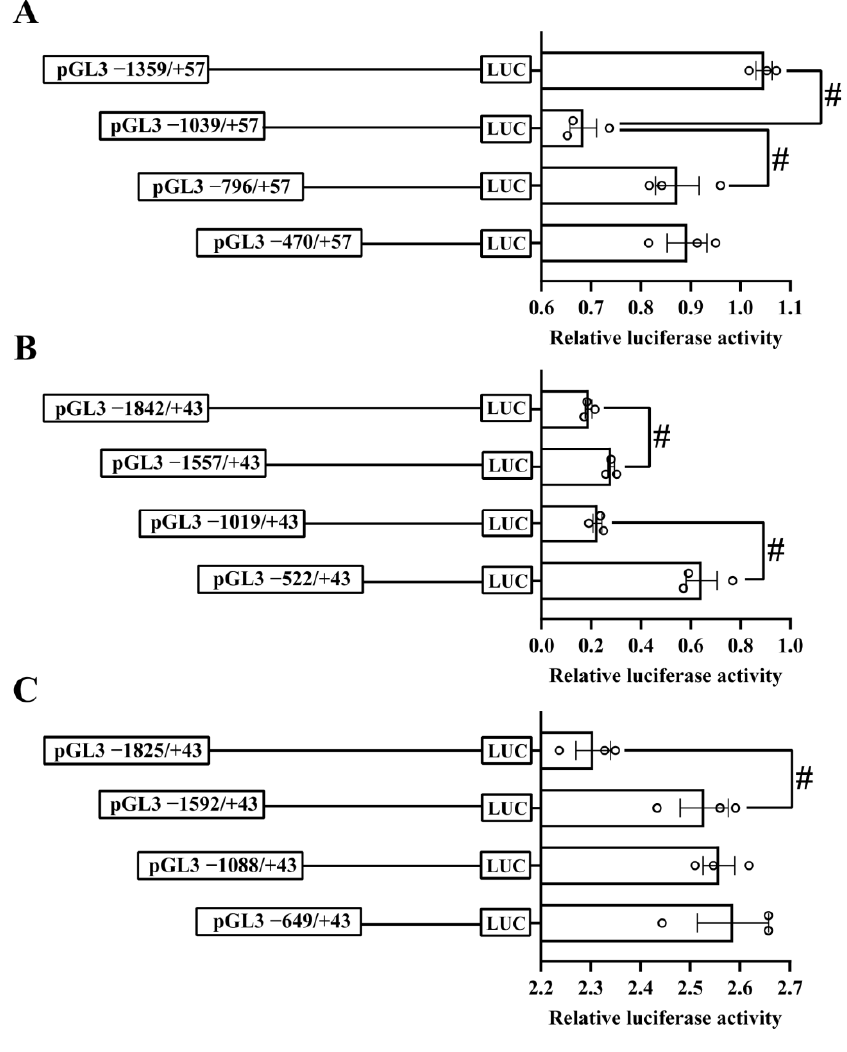
Figure 1. 5 ′ unidirectional deletion assays of ctr1 ( A ), ctr2 ( B ) and atox1 ( C ) promoters of yellow catfish. Values mean the ratio of activities of Firefly to Renilla luciferase. Results are presented as means ± SEM (n = 3). Hash symbol (#) means significant differences between two groupss ( p < 0.05).